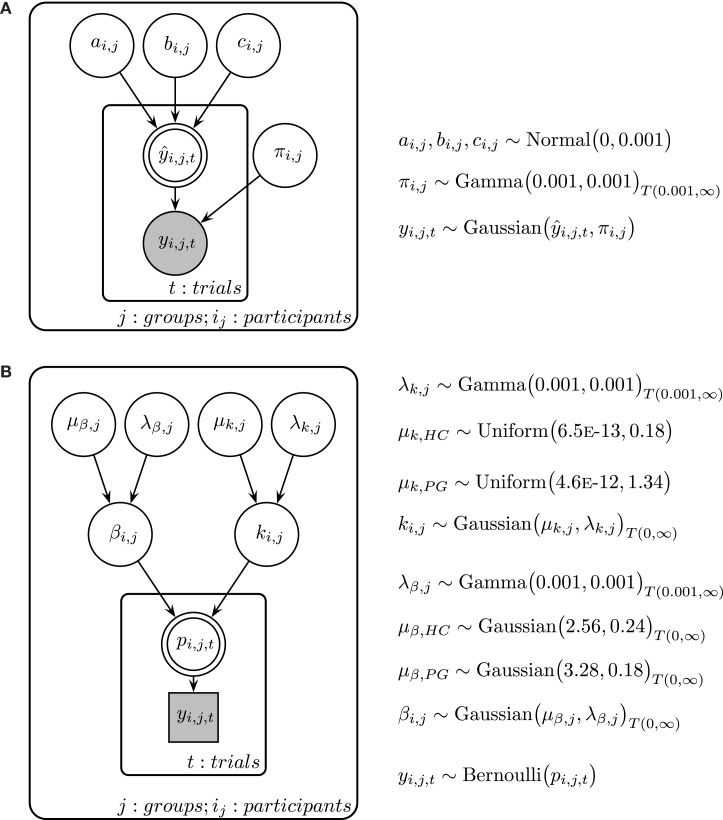
(A) Graphical description of the Bayesian model fit for time perception ratings and circle-size ratings. y^ is calculated with either a linear, a quadratic, or a power function, with the respective participant-specific parameters a, b, and c (see Materials and Methods in the text for more details). π is the participant-specific precision parameter and y is the measured ratings of the participant. (B) Graphical description of the Bayesian model fit for temporal discounting. μβ is the group mean prior of the β parameter and λβ is the respected precision parameter. μk is the group mean prior of the k parameter and λk is the respected precision parameter. Participant-specific β and k parameters are drawn from separate group distributions for HC and PG. β and k parameters determine the choice probability p in every trial, which is connected to the actual choice y. Shaded nodes indicate observed variables, while latent nodes are non-shaded. Round nodes are continuous quantities and squared nodes are discrete quantities. Double-bordered nodes are fully determined by their parent nodes.